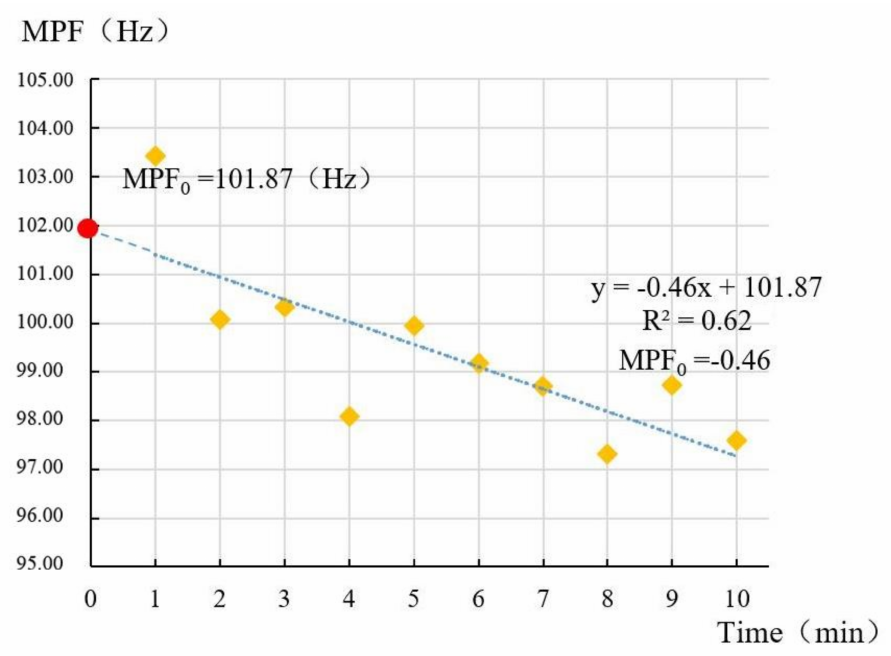
Figure 5. Linear regression of the MPF of the multifidus muscle in task VD250 (subject 1). The MPF data (10 sections) are plotted as a function of time (min) for each task, and the slope coefficient and MPF − intercept were